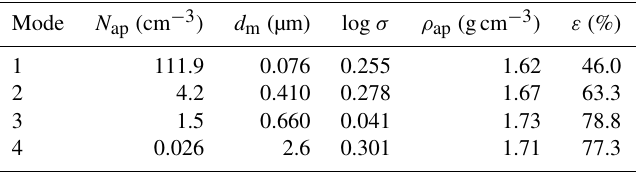
Table 2. Physical properties of aerosol particles. For each mode N ap is the particle concentration, d m is the median diameter, σ is the geometric standard deviation, ρ ap is the density of aerosols and ε is the soluble fraction of the mode.